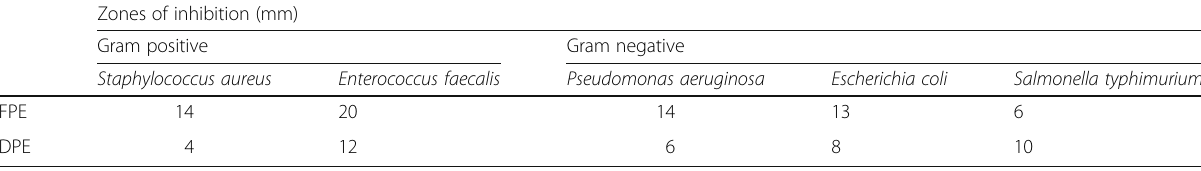
Table 1 Antibacterial activities of Citrus sinensis peel extracts (200 μ g/mL) against some bacterial strains tested by disc diffusion assay Zones of inhibition (mm)